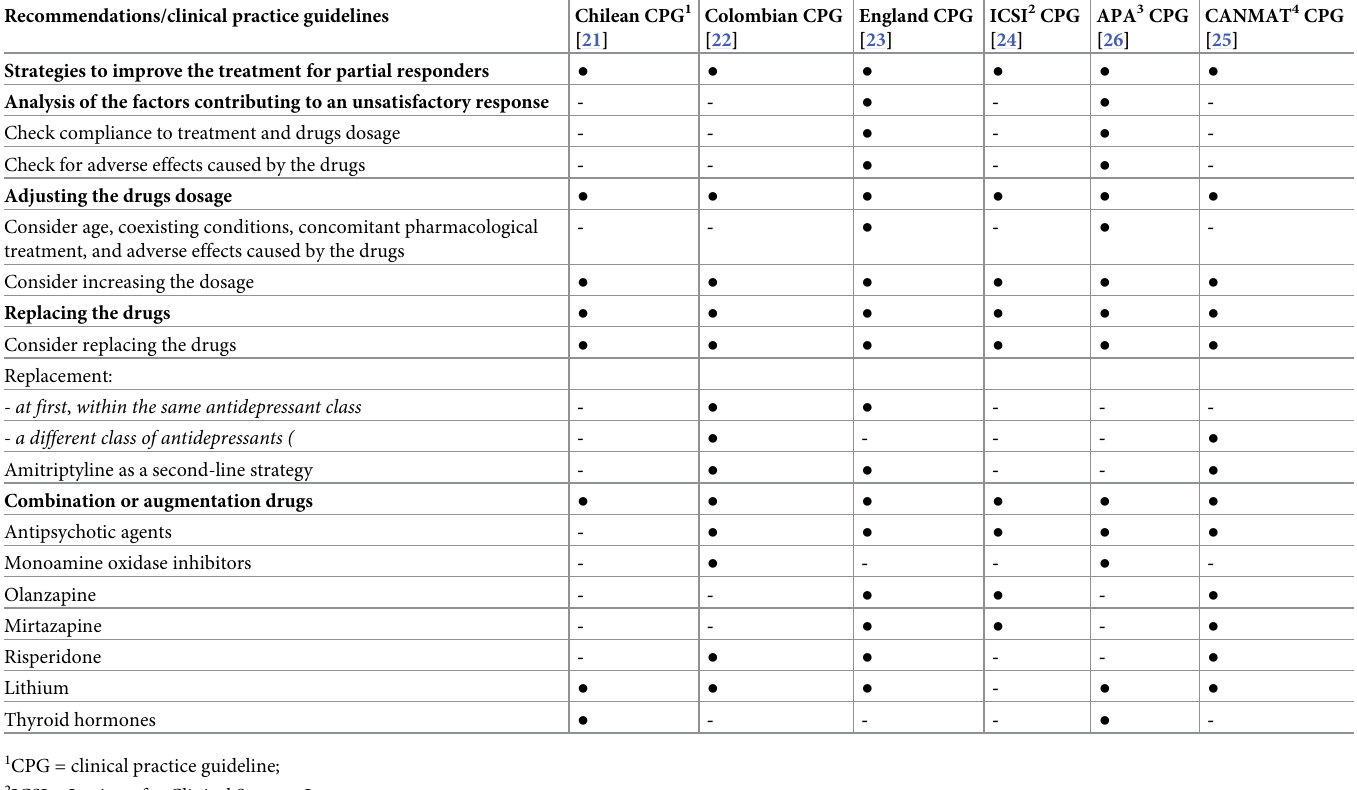
Table 3. Clinical practice guidelines for the pharmacological treatment of depression: Patients with a partial or no